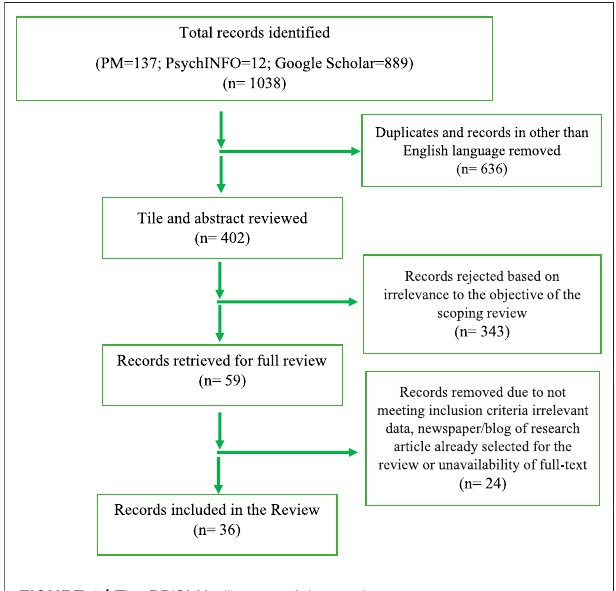
FIGURE 1 | The PRISMA diagram of the